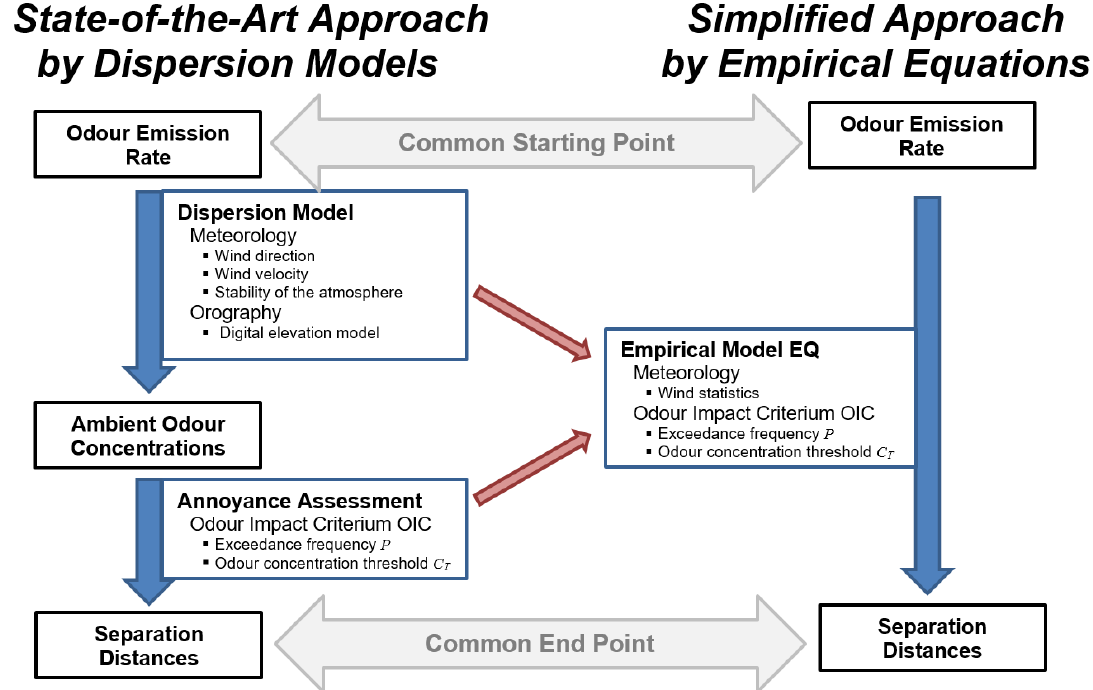
Figure 3. Schematic diagram of the state-of-the-art determination of separation distances by the use of a dispersion model (left side) and the simplified approach shown by the Austrian and German EQs (right side).